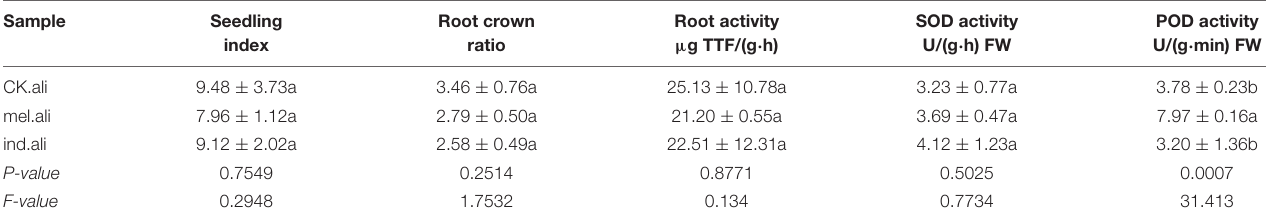
FIGURE 2 | Structural characteristics of Quercus aliena root tips with or without Tuber partner. (A) Cross section of Tuber indicum ectomycorrhizae, Scale bar = 50 µ m; (B) Q. aliena roots without Tuber partner, Scale bar = 40 µ m; (C) Tuber melanosporum ectomycorrhizae, Scale bar = 50 µ m; (D) longitudinal section of T. indicum ectomycorrhizae Scale bar = 50 µ m; (E) Q. aliena roots without Tuber partner, Scale bar = 50 µ m; (F) T. melanosporum ectomycorrhizae, Scale bar = 50 µ m; (G) mantle cell of T. indicum ectomycorrhizae, Scale bar = 20 µ m; (H) cell of root tips without Tuber partner, Scale bar = 50 µ m. (I) mantle cell of T. melanosporum ectomycorrhizae, Scale bar = 20 µ m. TABLE 1 | Physiological indices of Quercus aliena